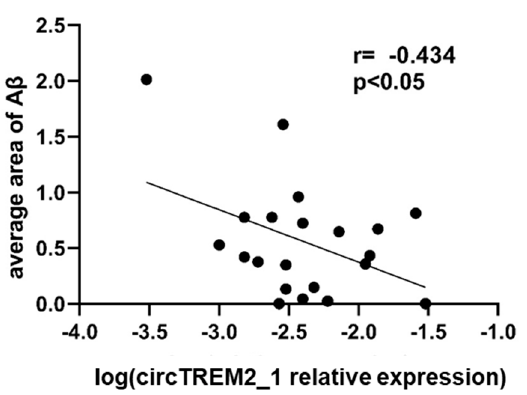
Figure 4. circTREM2 and A β deposits correlation. Dispersion diagram showing negative correlation between global average area of A β deposits and circTREM2_1 expression levels.